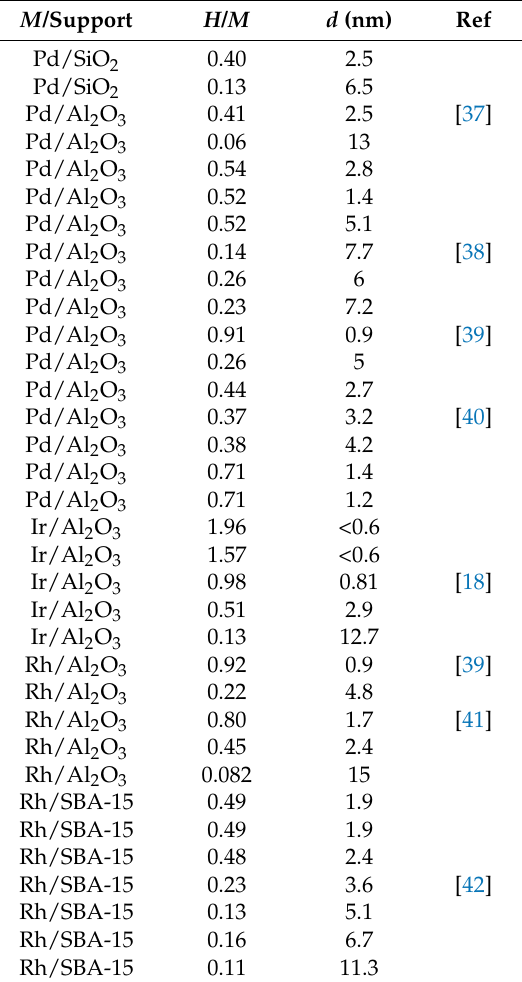
Table 3. Literature results of H 2 chemisorption measurements and average particle sizes (determined by TEM) for Pd, Ir, and Rh